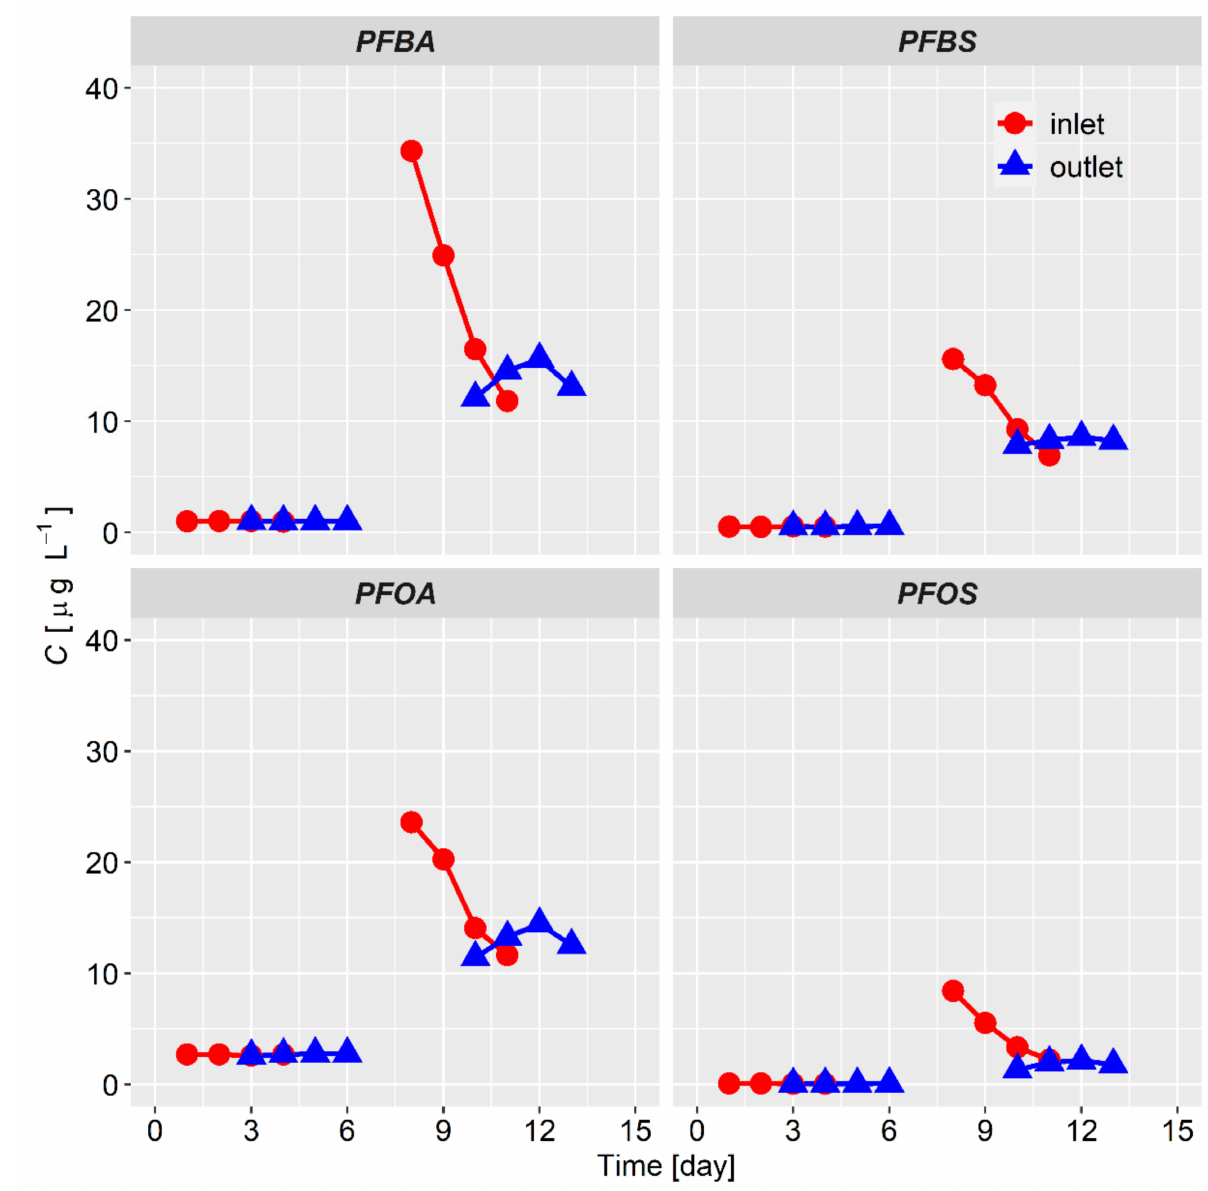
Figure 3. Congener concentrations before the PFAA spike (from day 1 to day 6) and after the PFAA spike (from day 8 to day 13). The red markers indicate the values of the inlet averaged daily samples whereas the blue markers indicate those of the